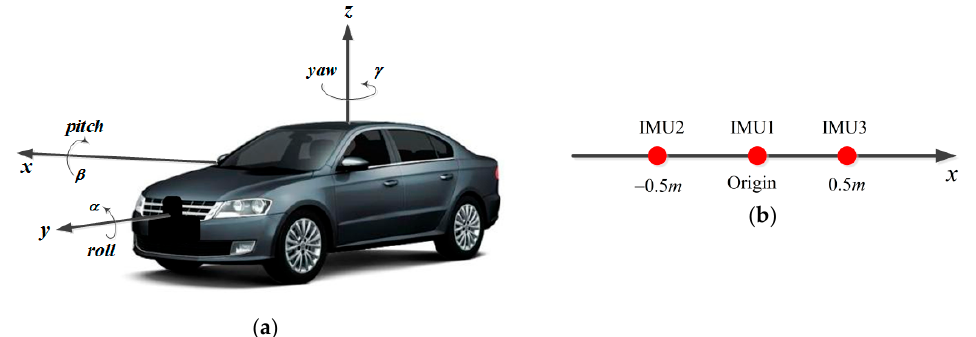
Figure 3. The structure diagram of multiple inertial measurement units (IMUs). ( a ) Vehicle’s general view; ( b ) partial enlarged details for internal structure.